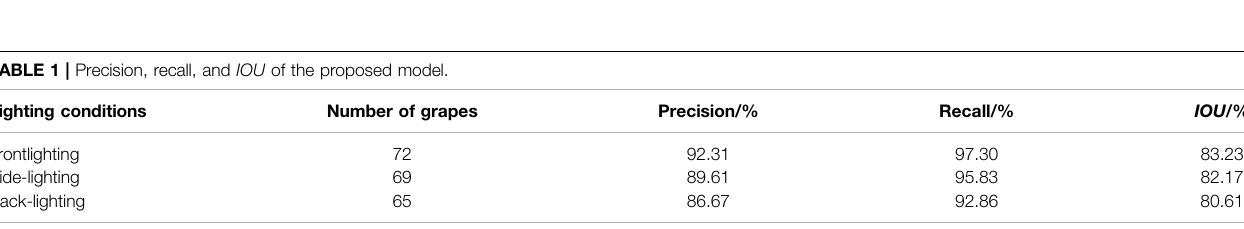
FIGURE 10 | Detection results and point cloud segmentation results: (A) original images, (B) Mask R-CNN, (C) original point cloud, and (D) segmentation results.